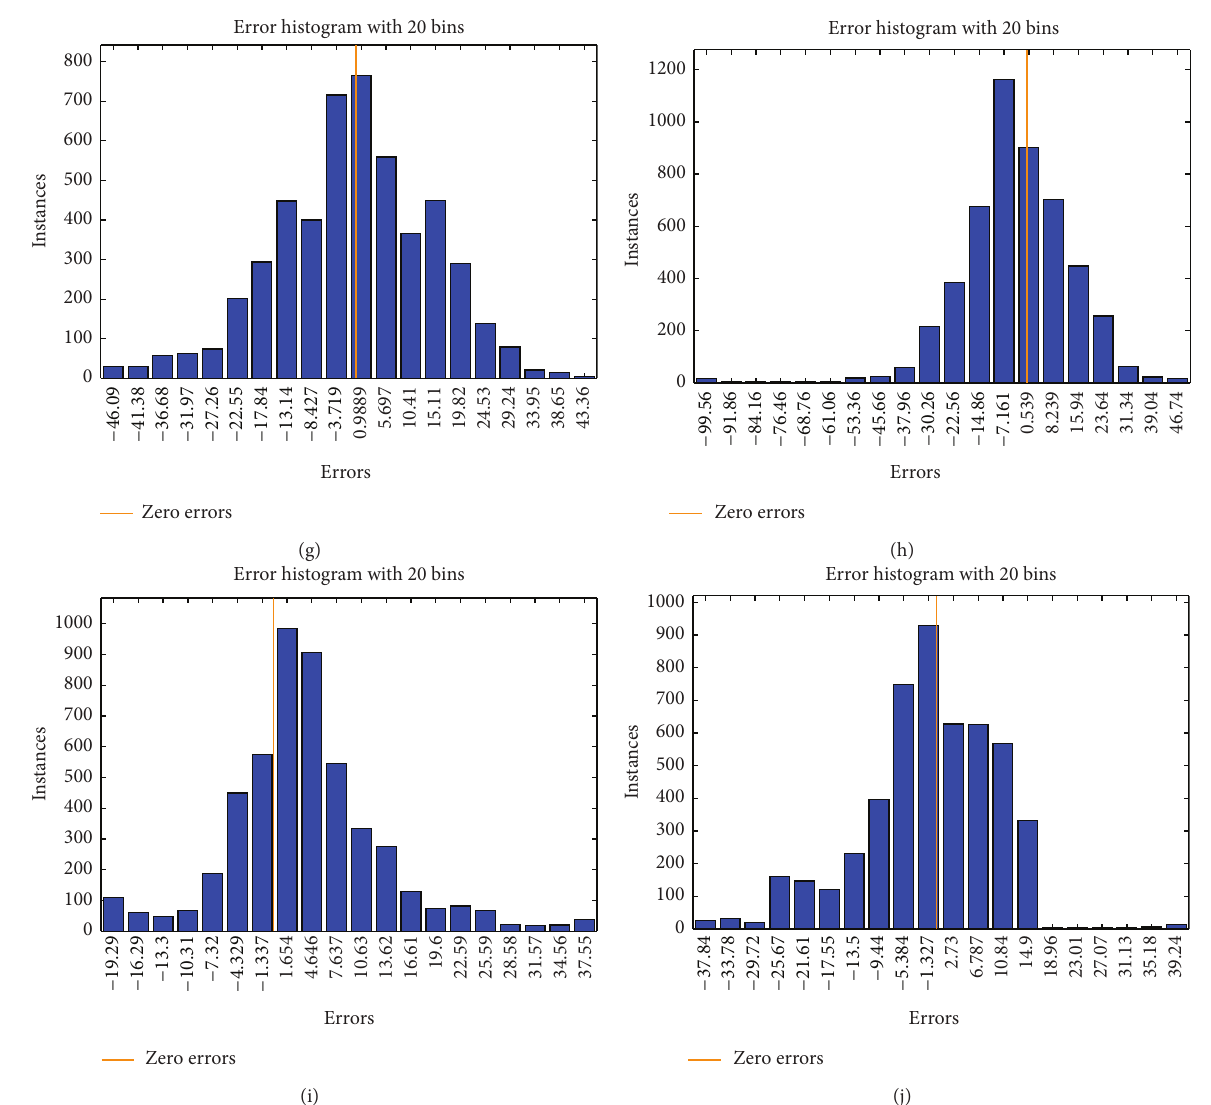
Figure 14: Error histograms of enhanced model for test data set (5000 samples). In the figure, (a) is joint angle ( 𝐽 = 𝐽 𝑛 ), (b) is left muscle force ( 𝐽 = 𝐽 𝑛 ), (c) is right muscle force ( 𝐽 = 𝐽 𝑛 ), (d) is left muscle pressure ( 𝐽 = 𝐽 𝑛 ), (e) is right muscle pressure ( 𝐽 = 𝐽 𝑛 ), (f) is joint angle ( 𝐽 = 11𝐽 𝑛 ), (g) is left muscle force ( 𝐽 = 11𝐽 𝑛 ), (h) is right muscle force ( 𝐽 = 11𝐽 𝑛 ), (i) is left muscle pressure ( 𝐽 = 11𝐽 𝑛 ), and (j) is right muscle pressure ( 𝐽 = 11𝐽 𝑛